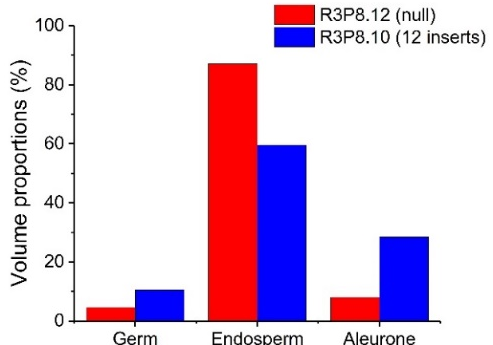
Figure 8. Proportions of volumes of different seed tissues determined by X-ray microtomography of mature wheat grains from field grown plants. AsWRI1 -wheat line with 12 gene inserts (R3P8.10) and in control (null, R3P8.12). Results are from data from X-ray scans of single seeds.